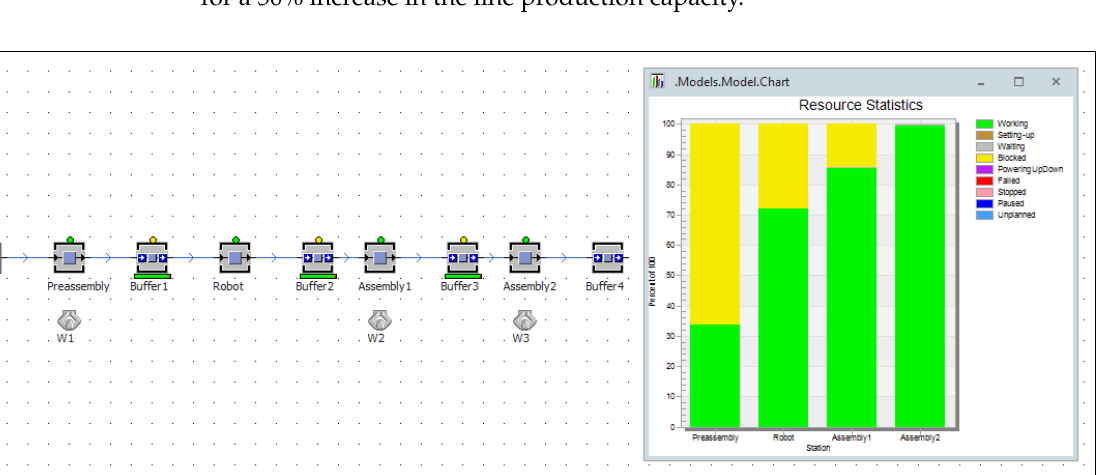
Figure 5. Variant 1b (one robot, four people). Variant 2a (V2a). In investment variant V2a, there are two robots in a parallel ar- rangement for welding and sealing operations. Robots perform both operations. There are three workers on the line. The bottleneck is again the Assembly2 workplace (see Figure 6). The line, arranged in this way, can produce 291 pcs/8 h. The utilization of the Assem- bly1 workplace is more than 80%. The Pre-assembly workplace is only 35% loaded. The parallel robotic workstation is only 36% utilized, 49% waiting, and 15% of the time blocked. In the V2a variant, production will increase by approx. 109% (see Table 4).